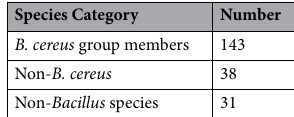
Table 1. Bacterial strains used to verify inclusivity and